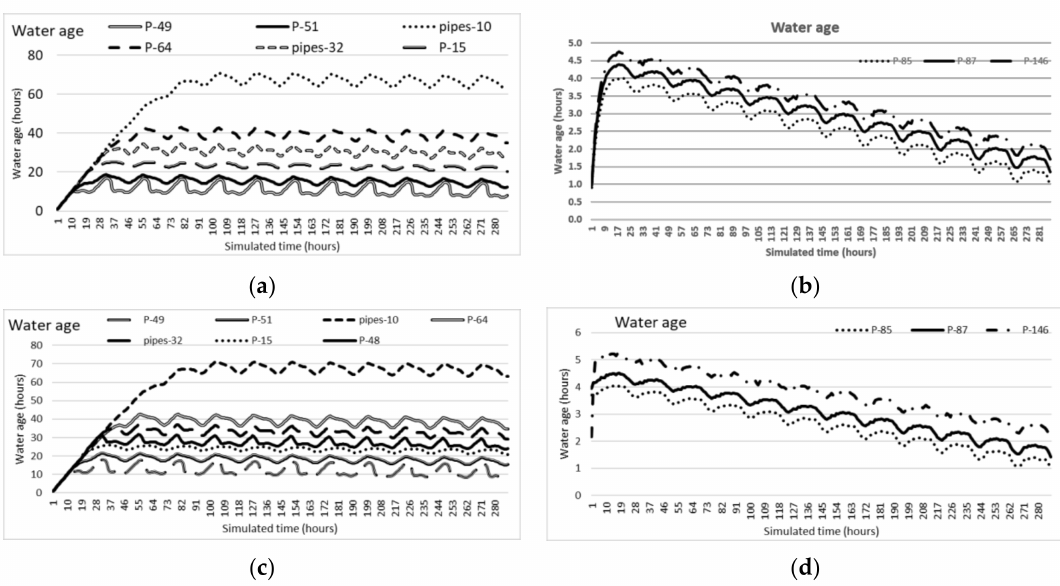
Figure 4. Water age of selected pipes: ( a , b ) for scenario A and ( c , d ) for scenario